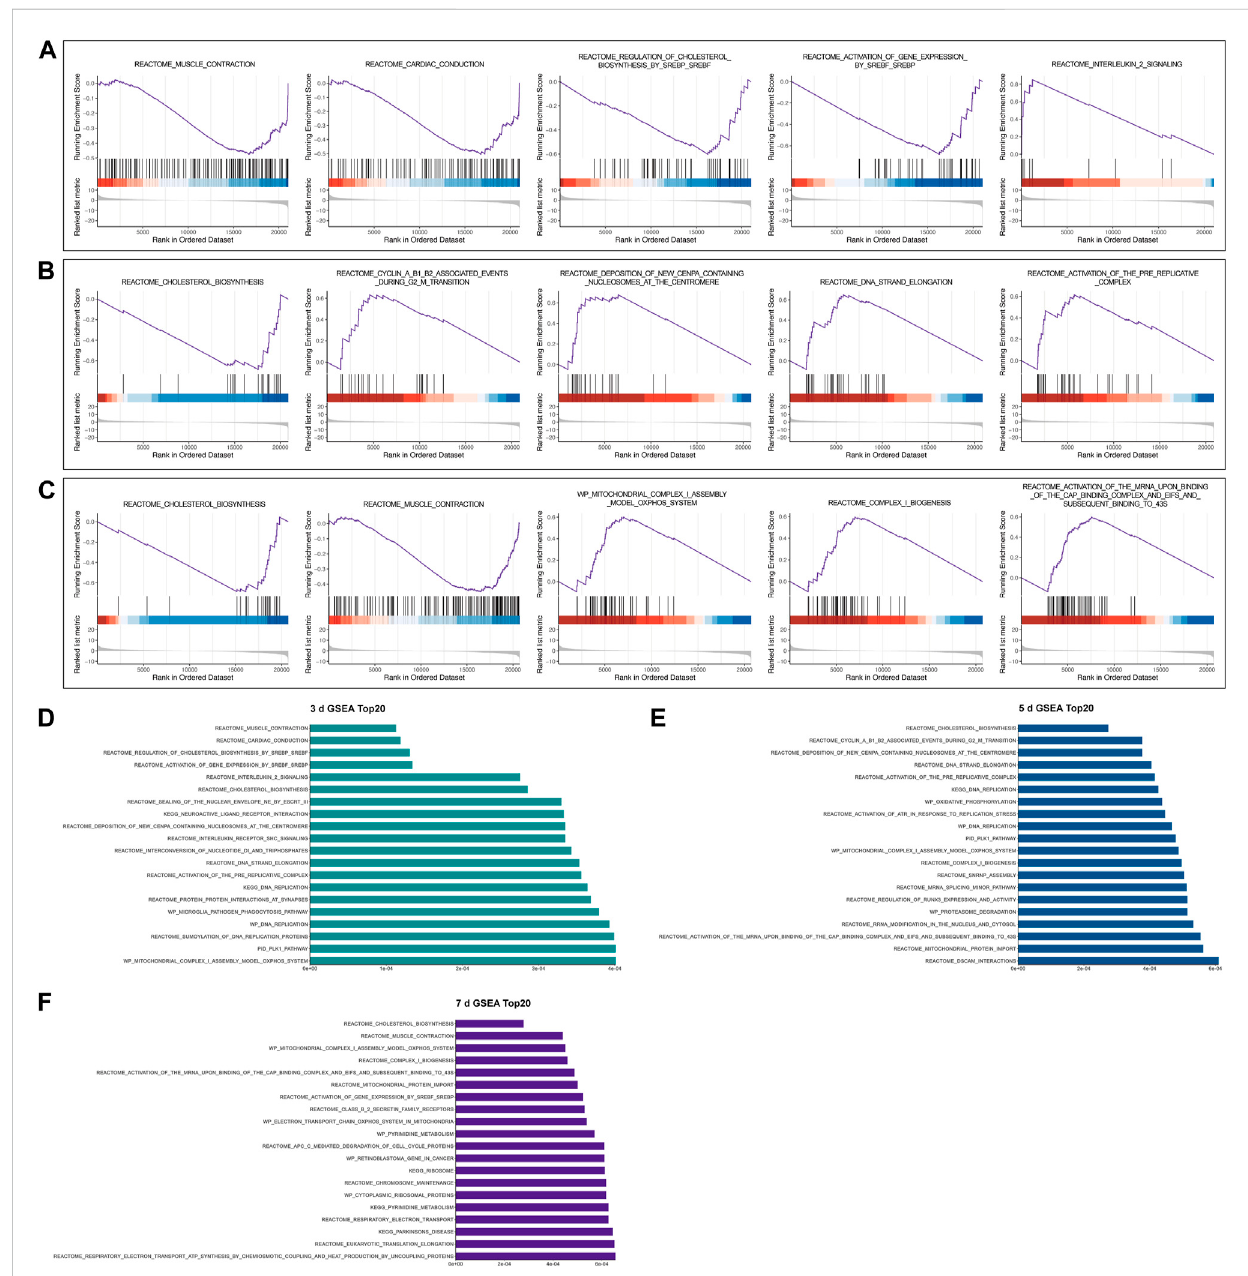
FIGURE 2 Representativeresultsofgenesetenrichmentanalysis(GSEA). (A-C) GSEAat3 days,5 days,and7 daysfollowingsciaticnervecrushinjurycompared to control, respectively. All gene sets satisfy adjusted p < 0.05, FDR < 0.25, |NES| > 1. (D-F) Top 20 results of GSEA in 3-day group, 5-day group, and 7-day group,